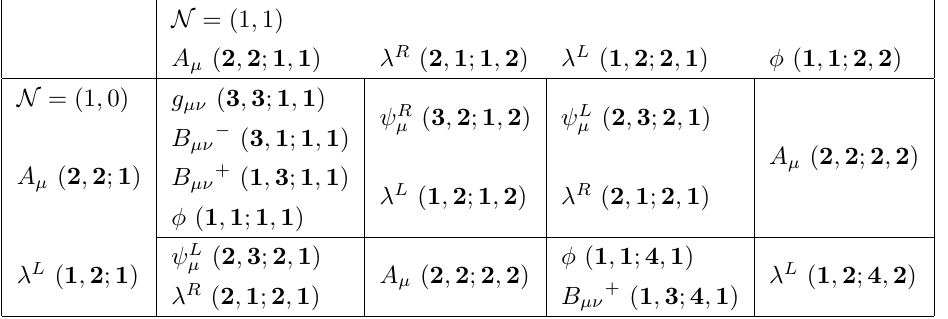
Table 5 . 6d N = (1 , 0) Yang-Mills tensor with N = (1 , 1)